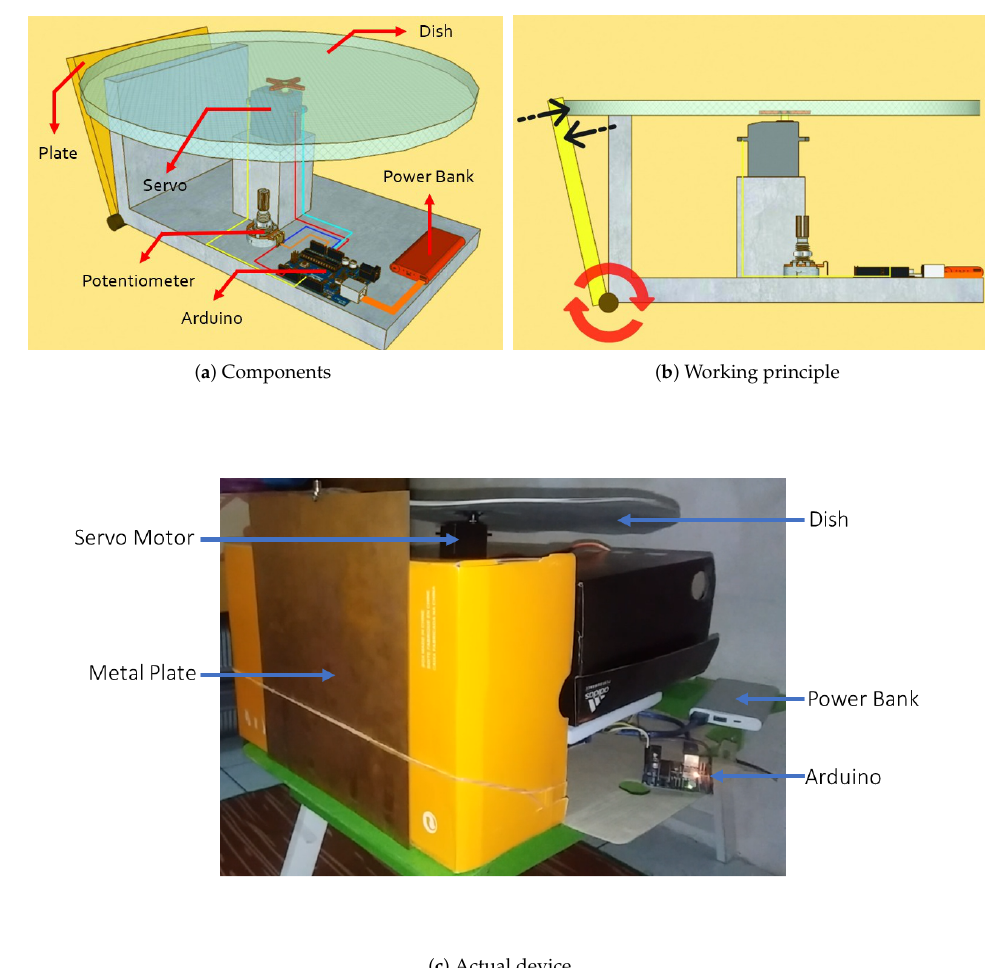
Figure 6. Breath vibrator design. Figure 6. Breath-vibrator